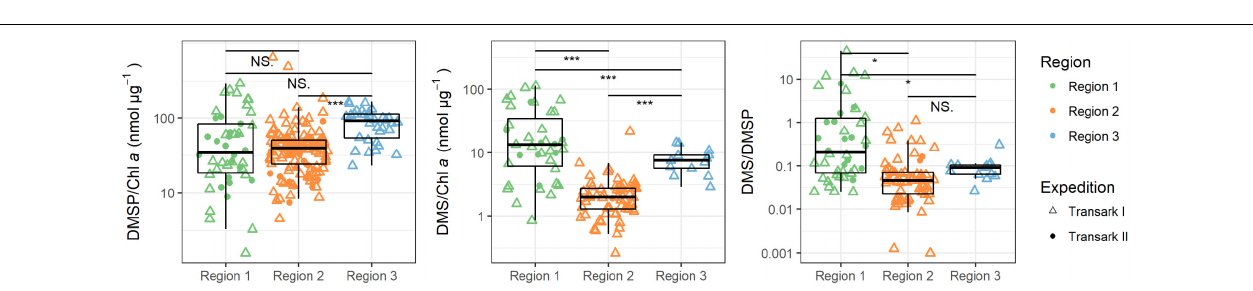
FIGURE 6 | Ratios of DMSP and DMS to chlorophyll a (Chl a ), and between DMS and DMSP in the upper 25 m water column during expeditions Transark I (triangles) and Transark II (circles) in the three regions. Confidence levels of Welch’s t -test for significant differences between means: 0.0001 ≤ ∗∗∗ p < 0.001, 0.01 ≤ ∗ p ≤ 0.05 < NS. ≤